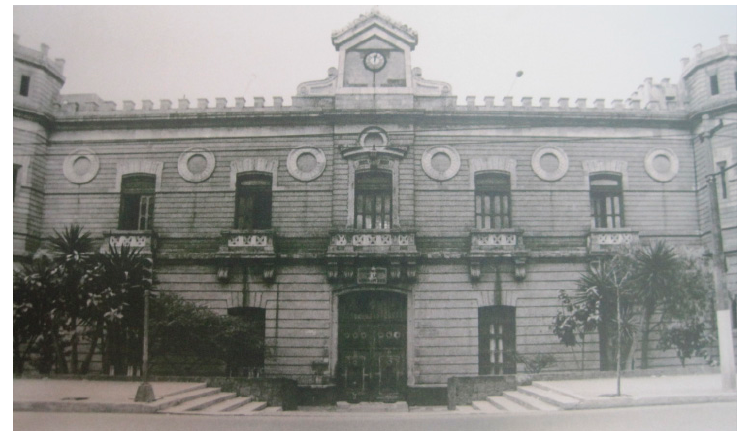
Figure 3. Frontal view of the building circa 1980 [11].